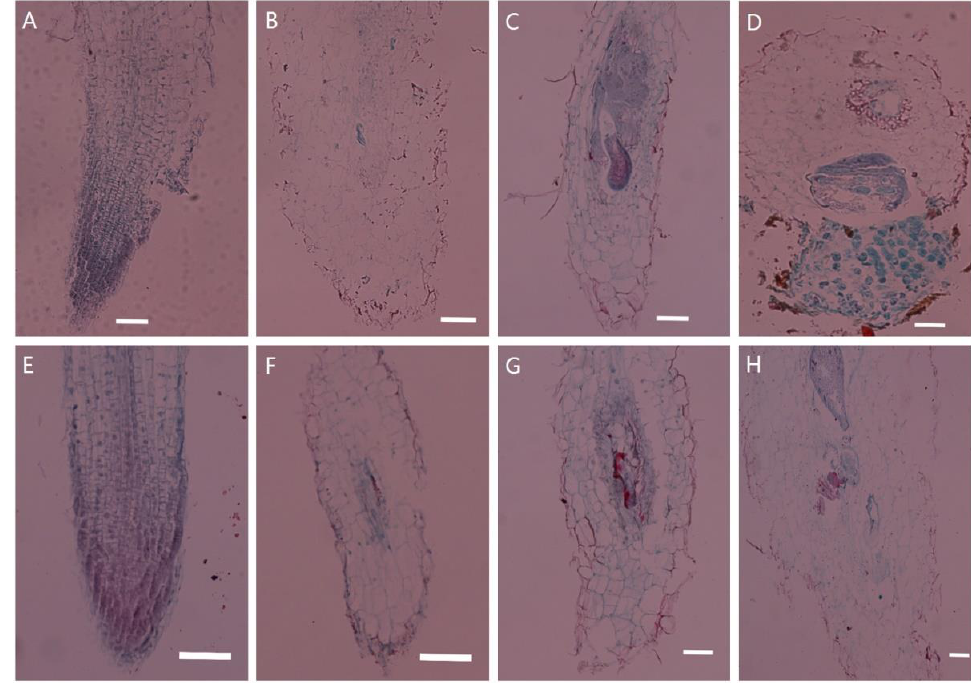
Figure 1. Tissue section to observe the disease resistance response of PsoRPM3 transgenic tobacco after nematode inoculation. The paraffin section technique was used to observe the nematode invasion status of tobacco roots infected by M. incognita, and to compare the difference in disease resistance between the transgenic and wild-type tobacco W38. ( A – D ) The observation of wild-type tobacco W38 roots which were inoculated with M. incognita at 0 d, 3 d, 14 d and 30 d as a negative control; ( E – H ) The observation of transgenic PsoRPM3 tobacco roots which were inoculated with M. incognita at 0 d, 3 d, 14 d and 30 d; scale bar is 100 μm.